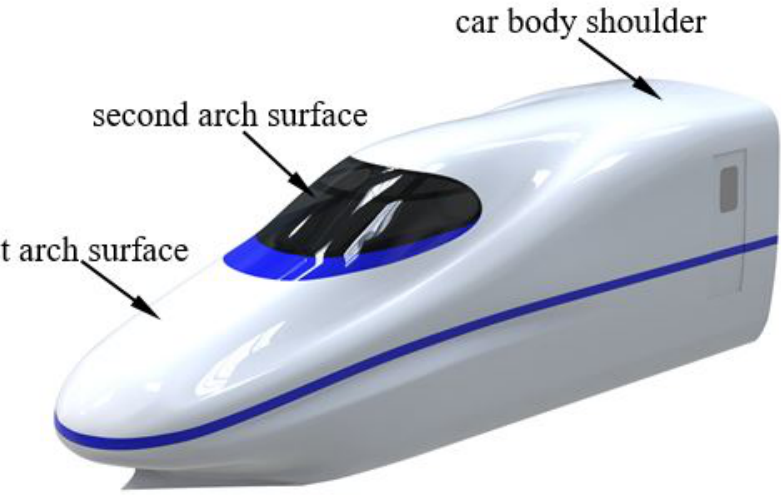
Fig. 1. Exterior shape of the driver’s cab